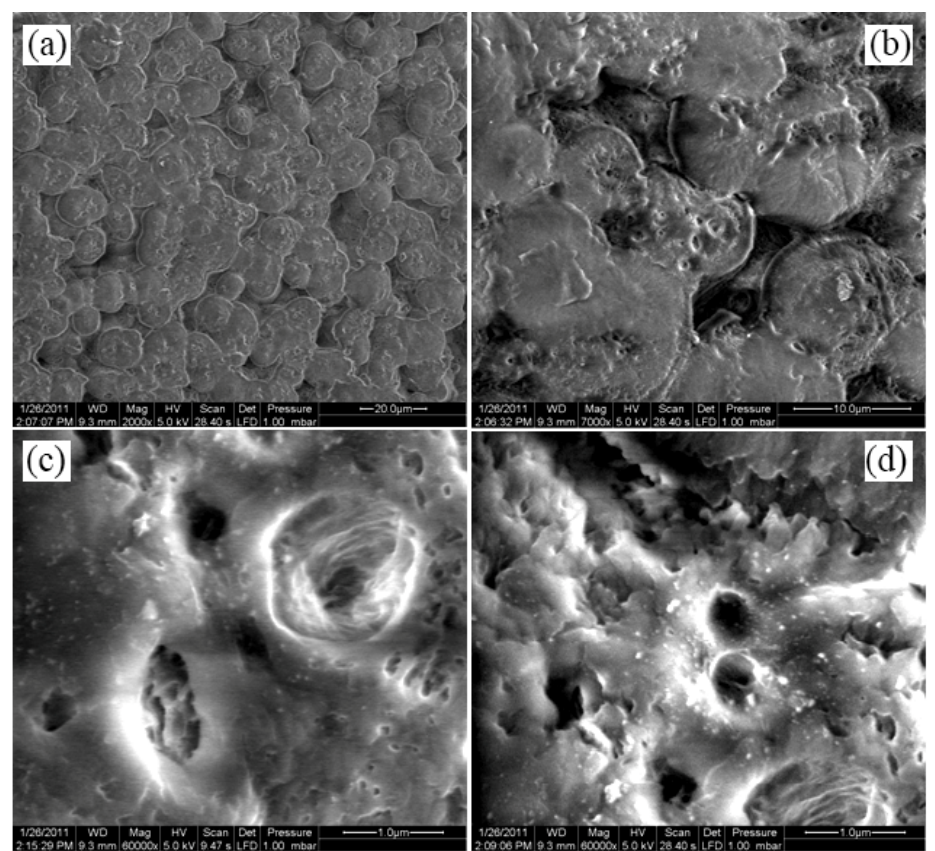
Figure 3. SEM micrograph of ( a ) the spherical surface of the HPA membrane, 2000× magnification; ( b ) Pore distribution on the surface of HPA, 7000× magnification; ( c ) and ( d ) Morphology of pores and surface of HPA, 60,000×